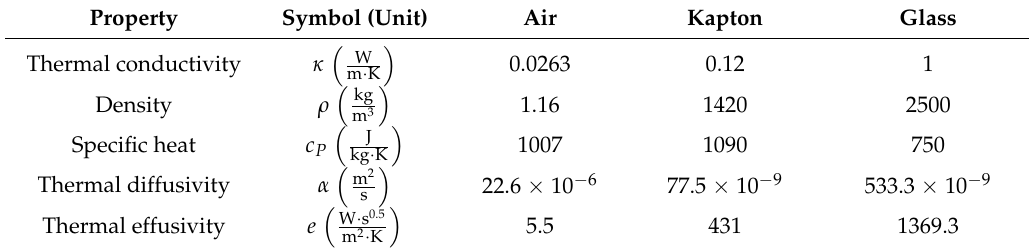
Table 2. Thermophysical properties of the materials.